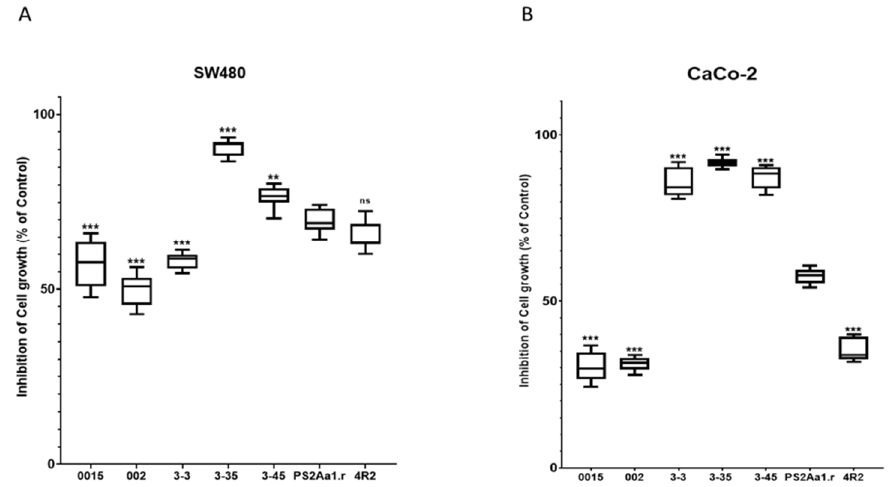
Figure 2. Tukey’s multiple comparison test for ( A ) SW480 and ( B ) CaCo ‐ 2. The results for the percentage of cell growth inhibition correspond to 5 μ g ∙ mL − 1 for each parasporin. PS2Aa1 was used as a control. ** p ≤ 0.01, and *** p ≤ 0.001, ns (non ‐ significant)